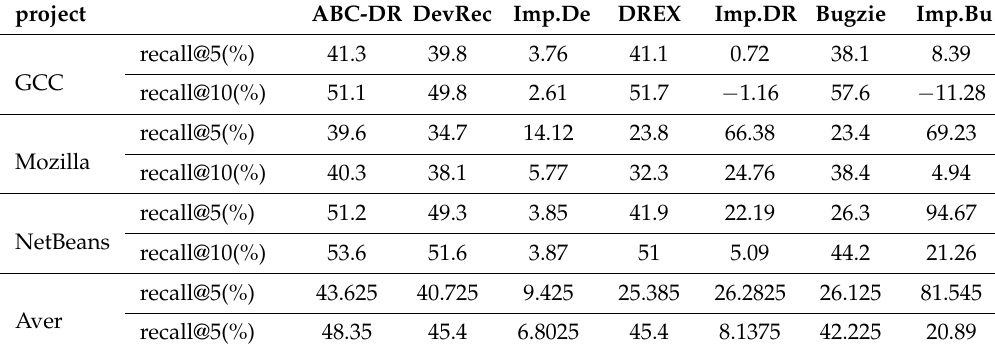
Table 4. precision@5 and precision@10 of our proposed ABC-DR and DevRec, DREX, and Bugzie. It also shows the improvement of ABC-DR over DevRec (Imp.De), the improvement of ABC-DR